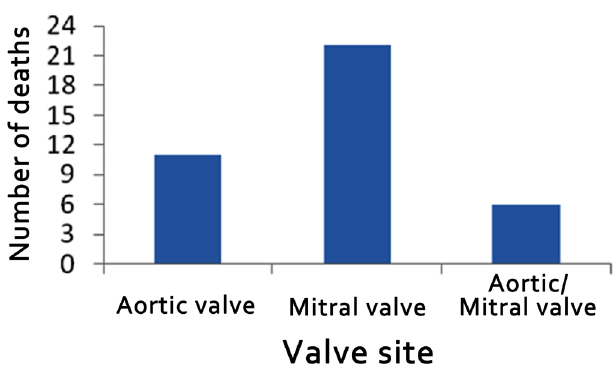
Fig. 3 - Number of deaths vs. Valve